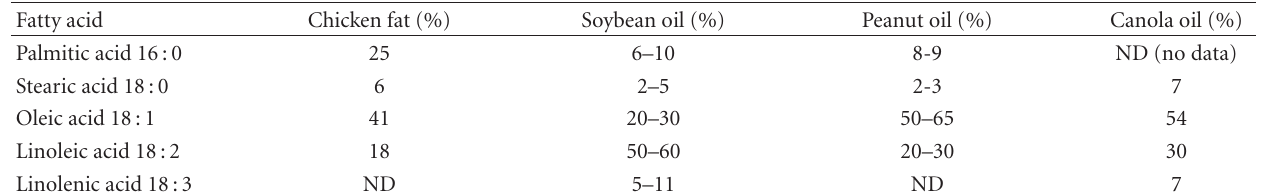
Table 1: Typical fatty acid contents for the four di ff erent fuels tested in this work, from [14, 15].